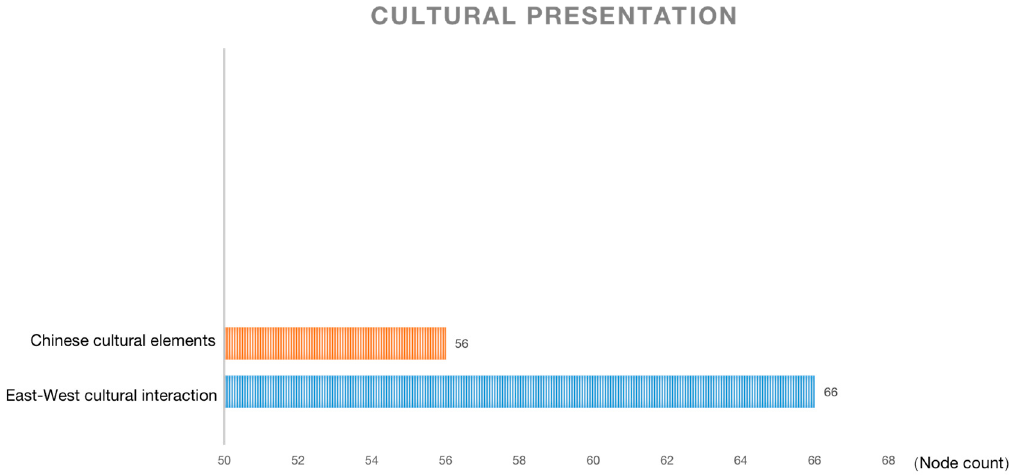
Figure 4. Cultural